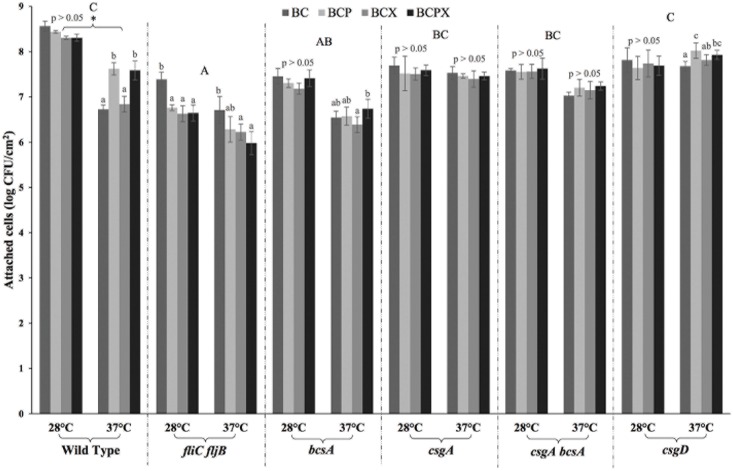
Attachment of S. Typhimurium ATCC 14028 (a) wild type, (b) ΔfliC fljB mutant, (c) ΔbcsA mutant, (d) ΔcsgA mutant, (e) ΔcsgA bcsA mutant and (f) ΔcsgD mutant grown at 28°C and 37°C to various BC composites (BC, BCP, BCX, BCPX).Different lowercase letters indicate significant differences in attachment numbers between different BC composites within each strain grown at a specific temperature (One-way ANOVA & Tukey’s pairwise comparison at p<0.05). Different uppercase letters indicate significant differences in attachment numbers to BC composites between different strains (One-way ANOVA & Tukey’s pairwise comparison at p<0.05). Asterisk sign indicates significant differences in attachment numbers for the same strain grown at two different temperatures (28°C and 37°C) (independent samples t-test at p<0.05).